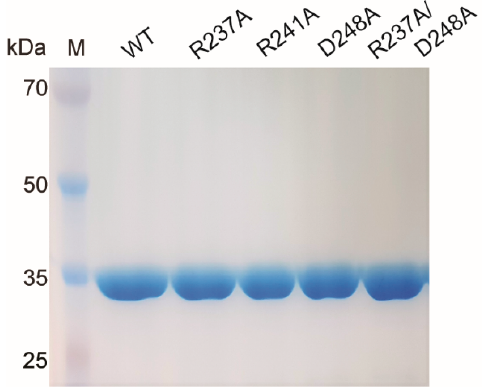
Figure 2. SDS-polyacrylamide gel after purification of WT and mutant PML enzymes using Q-Sepharose anion-exchange chromatography. M—marker.